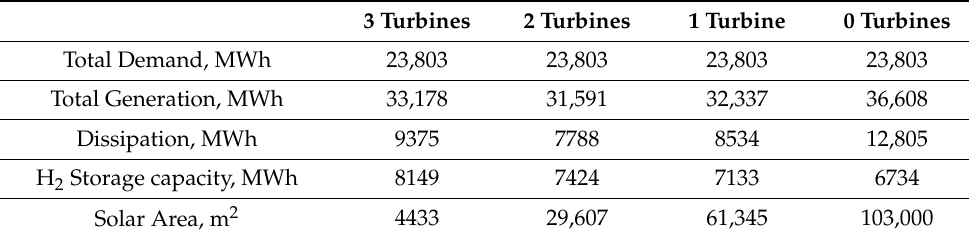
Table 1. Important parameters for the community of 2000 GIBs without thermal